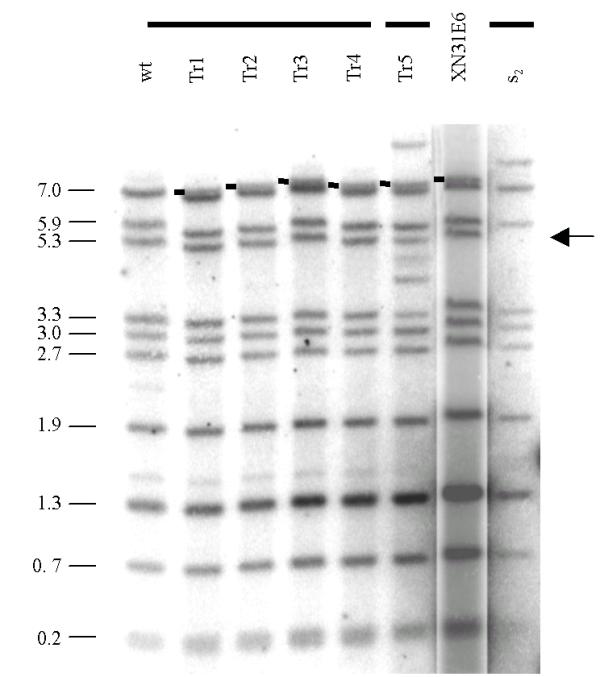
Southern blot analysis of XN31E6 transformants. XN31E6 cosmid DNA along with total genomic DNAs of wild type (wt) s2, and five transformants obtained by transforming s*789 with XN31E6 were digested by XhoI and hybridized with an XN31E6 probe. Wild type, Tr1, Tr2, Tr3, and Tr4 differentiate wild-type Secteurs (S), Tr5 has a mild S phenotype, and s2 is not able to differentiate Secteur(s). The 7-kb band corresponding to pMoCosX is marked by dark connecting lines. The arrow points to the 5.3-kb fragment, which shifts in s2.